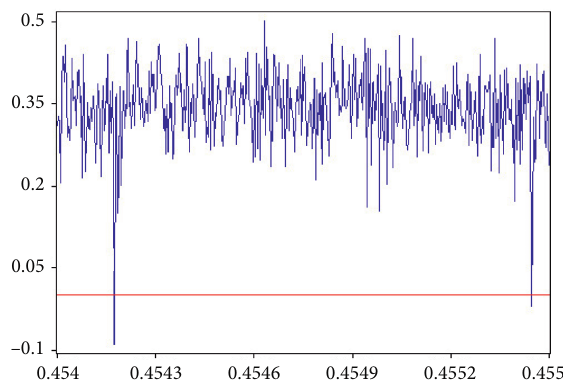
Figure 7: LLE with respect to κ and τ � − 0 . 2.